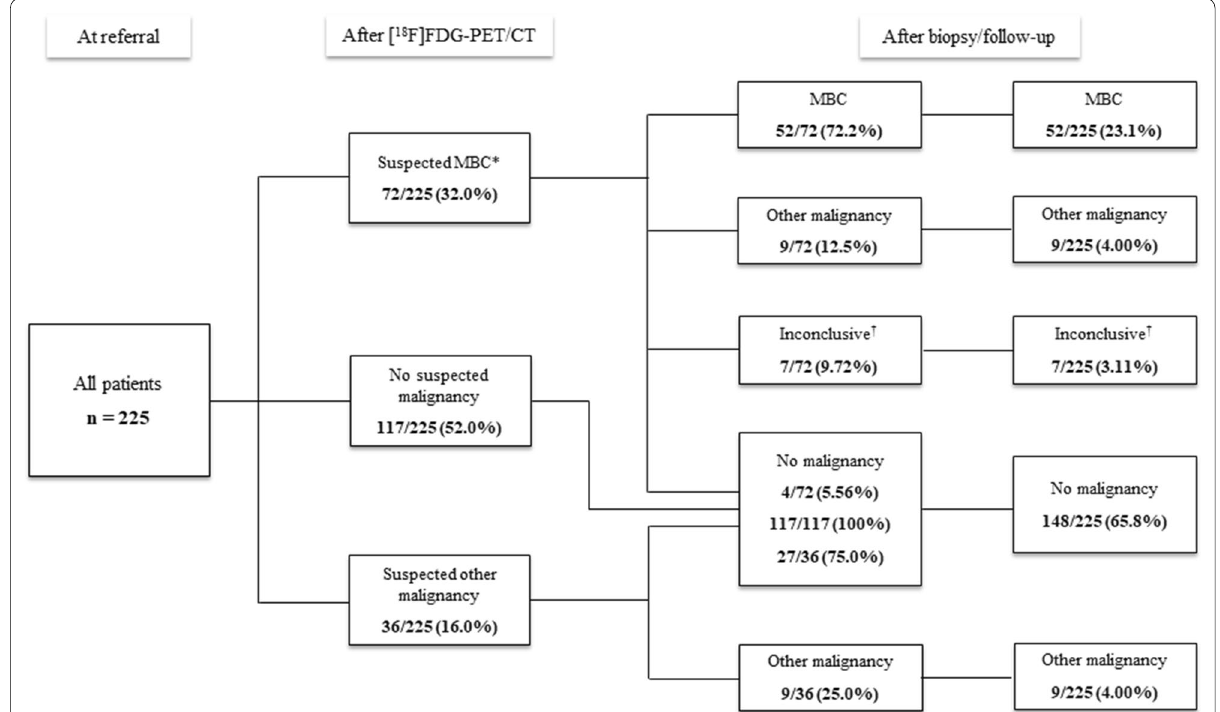
Fig. 3 Illustration of the pathway for 225 patients after [ 18 F]FDG‑PET/CT and biopsy/follow‑up, reflecting the results of the scan and final diagnostic workup. Footnotes : Metastatic breast cancer (MBC). *Ten patients suspected of MBC were also suspected of incidental findings. † A final diagnosis was not obtained due to an impossible biopsy procedure or the result of the biopsy being